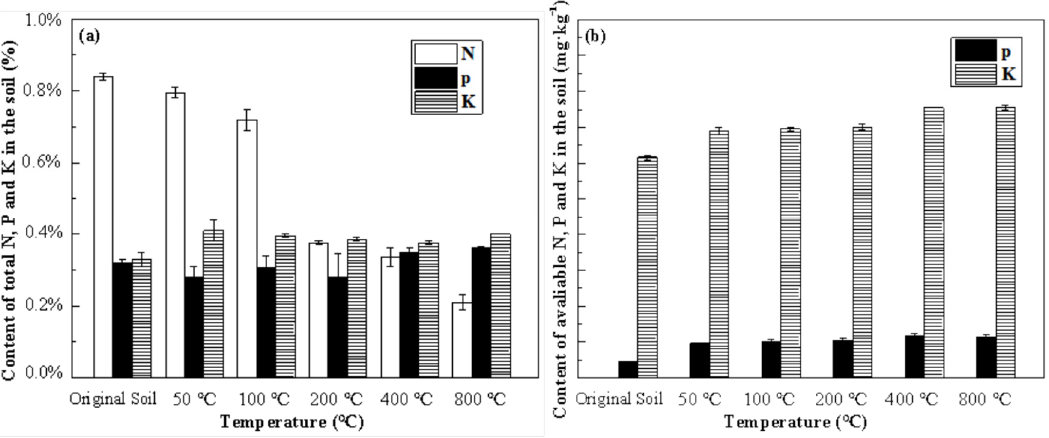
Figure 6. Influence of temperature on soil fertility: ( a ) total N, P, and K; ( b ) available P and K. The urease activity after culturing for 3 and 24 h for each temperature stage is shown in Figure 7. Before 50 °C, the urease activity of the 24-h culture was much higher than that of the 3-h culture, which indicated that the microbial population for enzyme production was adequate [32]. The urease activity decreased significantly when the temperature reached 100 °C for the 24-h culture. However, for the 3-h culture this happened when the temperature reach to 200 °C. This result might be caused by protein denaturation and the induced death of the microbes.